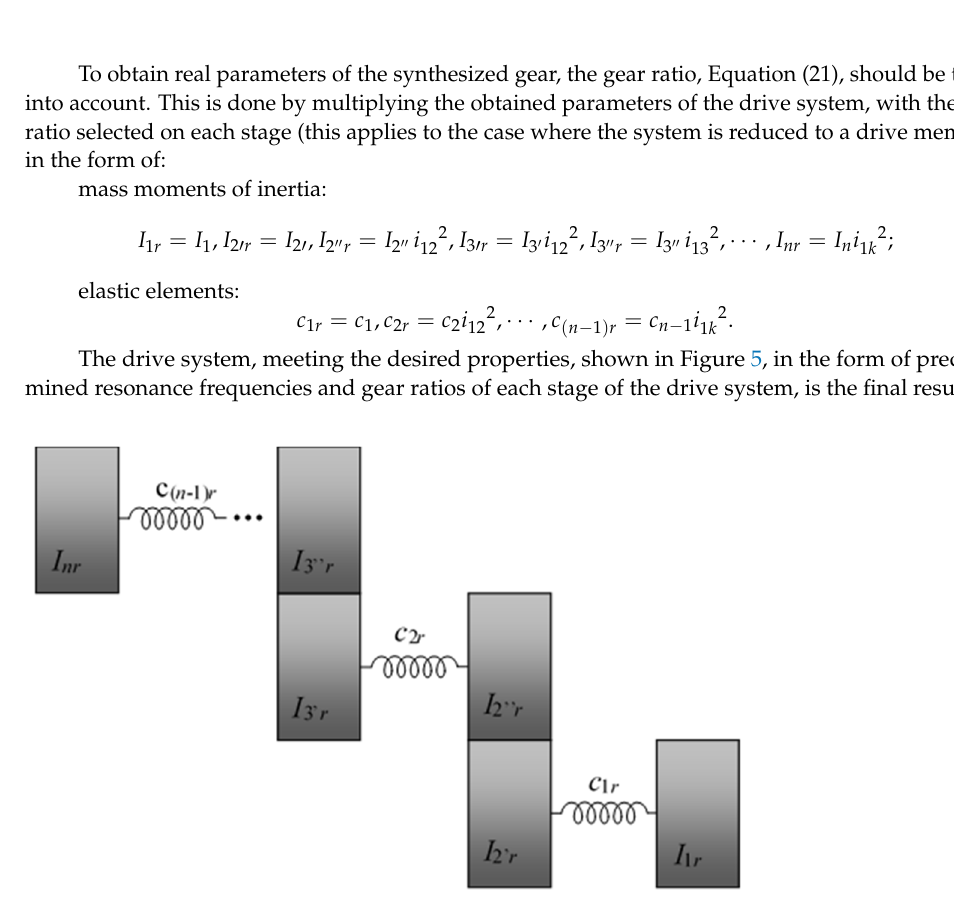
Figure 5. Model of the drive system including all the couplings.